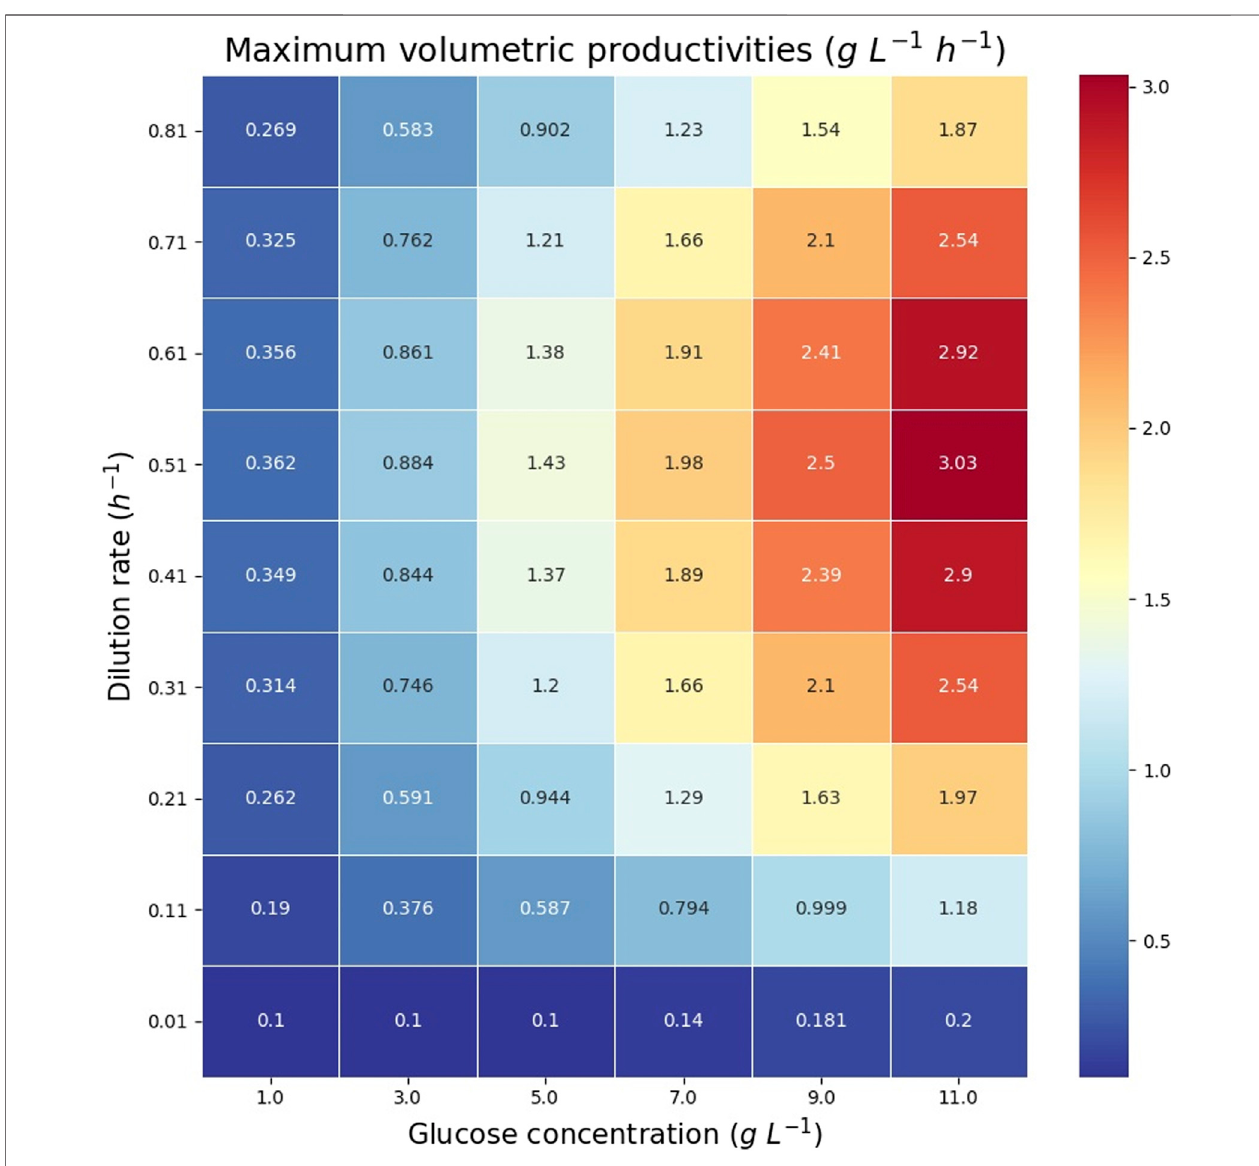
FIGURE 8 | Heatmap reporting the maximum volumetric productivities (VPs) for each glucose concentration and dilution rate.